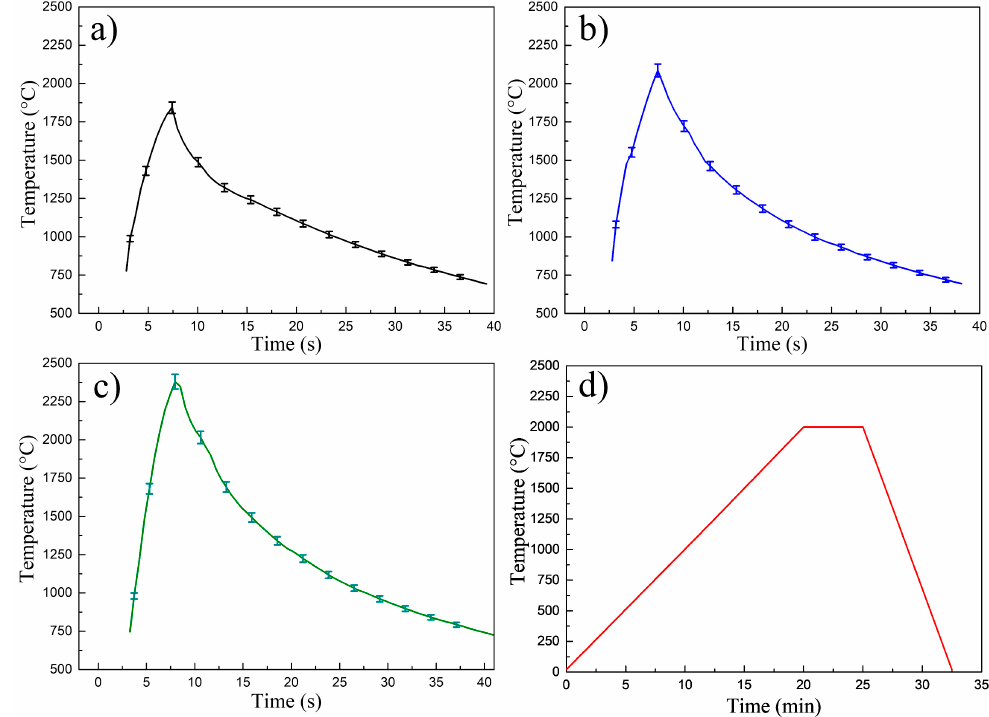
Figure 3. Experimentally recorded temperature profiles of ( a ) UFS 1, ( b ) UFS 2, ( c ) UFS 3 (temperature probing point T1 was 8 mm from the sample see Figure 4b, ( d ) SPS 4. Note the different time scales between SPS and UFS. As the UFS process was very rapid, it was very challenging to accurately measure the sample temperature. The pyrometer recorded the temperature profile on a blind hole